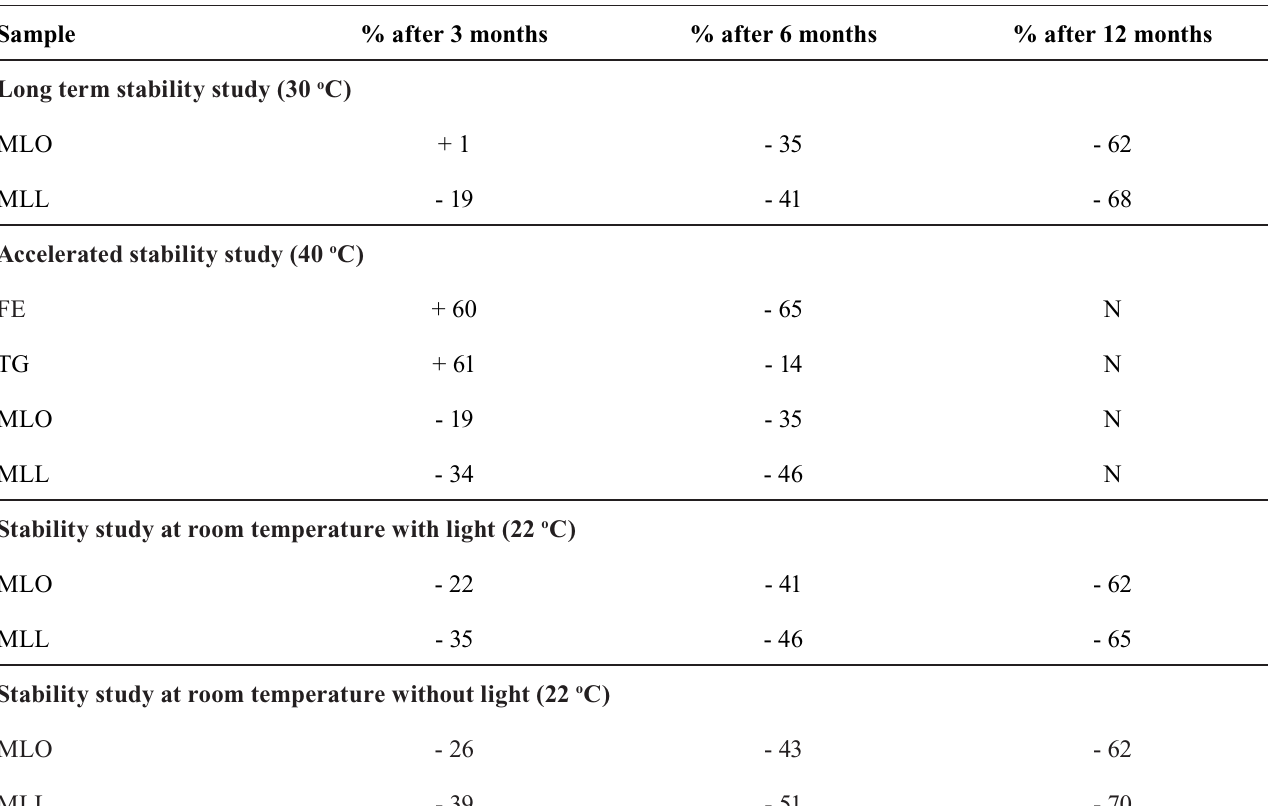
TABLE I - Percentage of coumarin reduction for the evaluated extracts